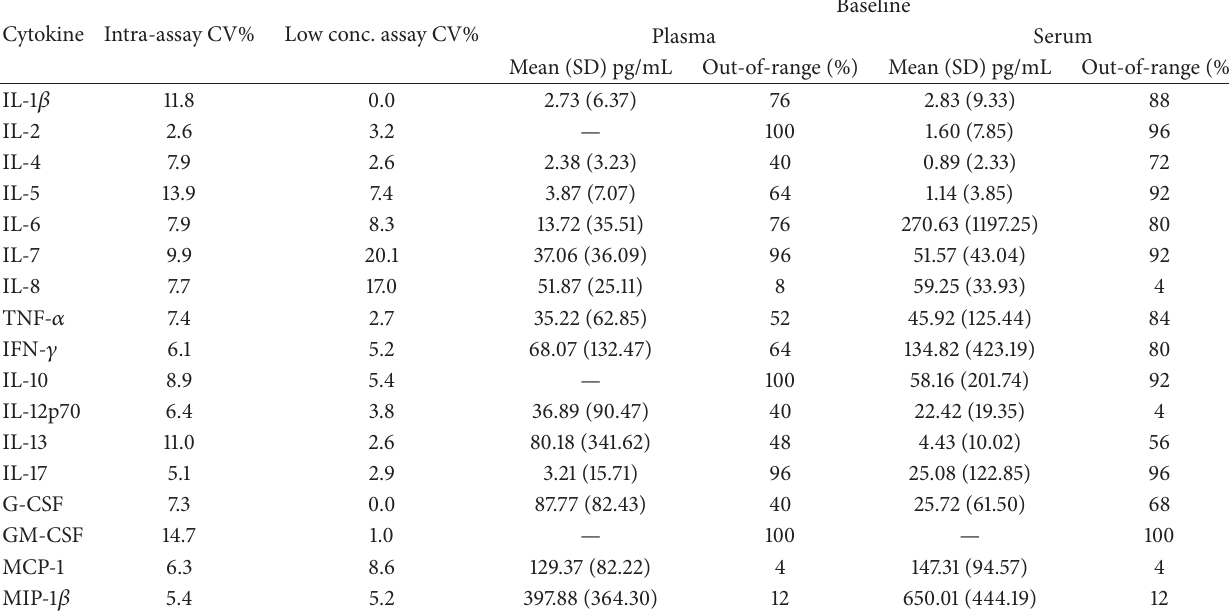
Table 2: Percentage of samples measured as below the assay detection limit or out of range in serum and plasma at the baseline condition. Each cell marked with “—” indicates that the analyte was not detectable in any sample. The intra-assay coefficient of variation (CV%) and the low concentration CV% are provided for each